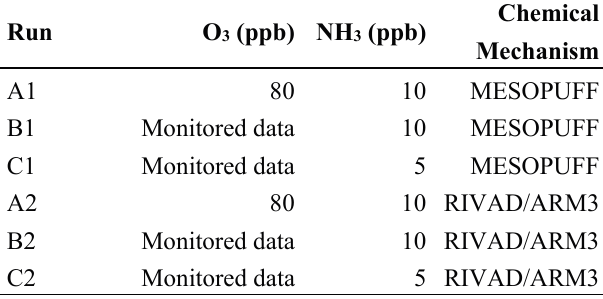
Table 2. Characteristics of different Calpuff runs for the estimation of secondary particulate matter (PM 2.5 ) emitted by the coal power plant located in Brindisi (Italy). Year